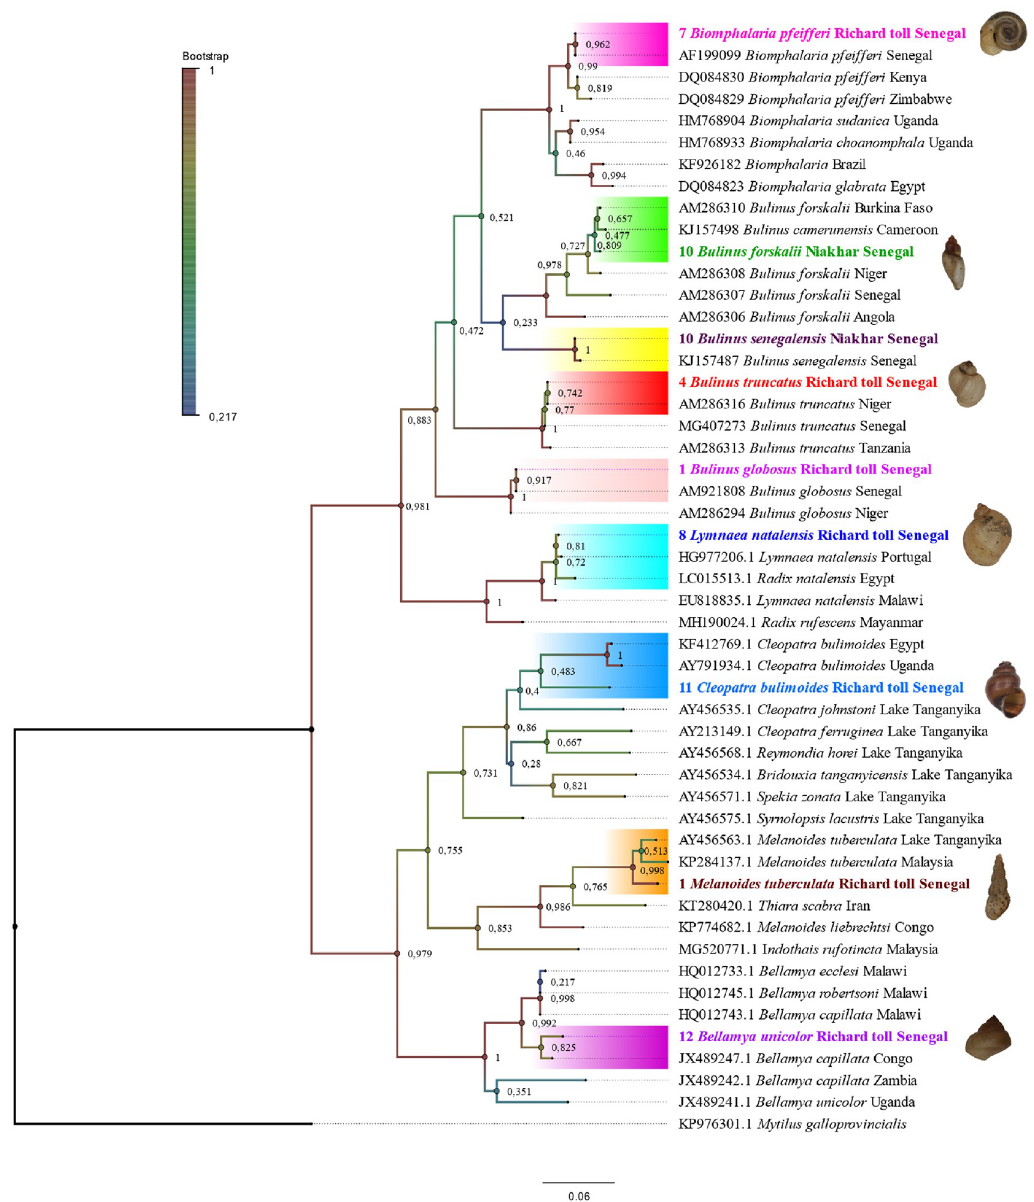
Fig 6. Phylogenetic tree showing the position of nine snail species ( Bi . pfeifferi , Bu . truncatus , Bu . forskalii , Bu . senegalensis , Bu . globosus , Be . unicolor , M . tuberculata , L . natalensis , and C . bulimoides ) used in this study. The tree was constructed using the maximum likelihood method based on the Kimura 2-parameter distance (MEGA7). The values on the branches are bootstrap support values based on 1000 replications. Branches are colour-coded to the bootstrap values. The identity of each taxon is colour-coded conforming to the